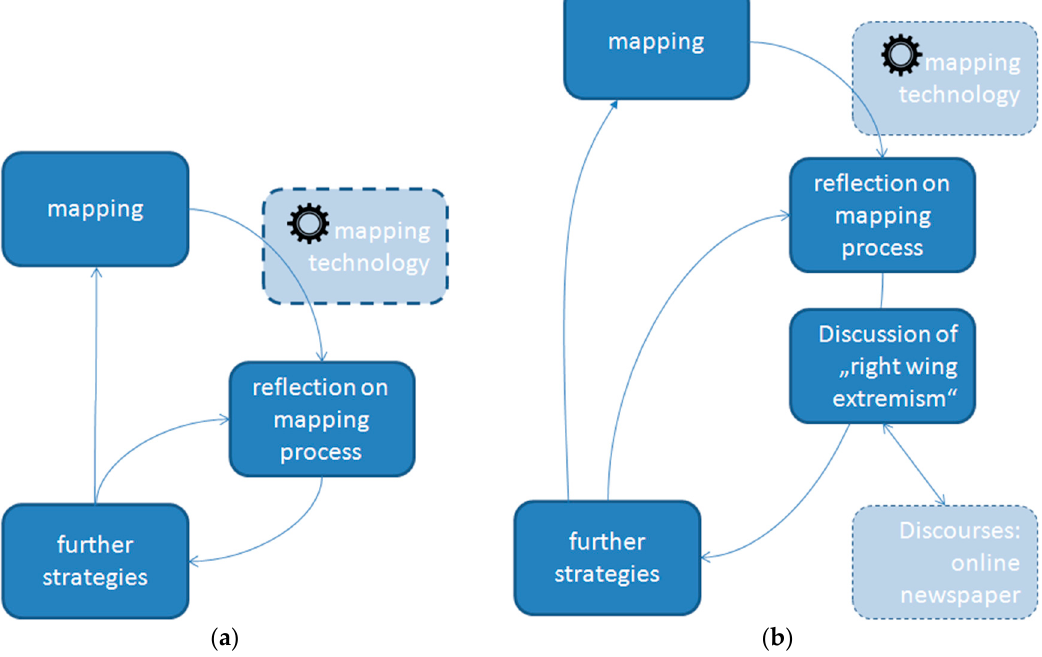
Figure 2. Differing implementations: ( a ) Implementation in Salzburg autumn 2016; and ( b ) implementation in Vienna spring 2017 (own diagram).